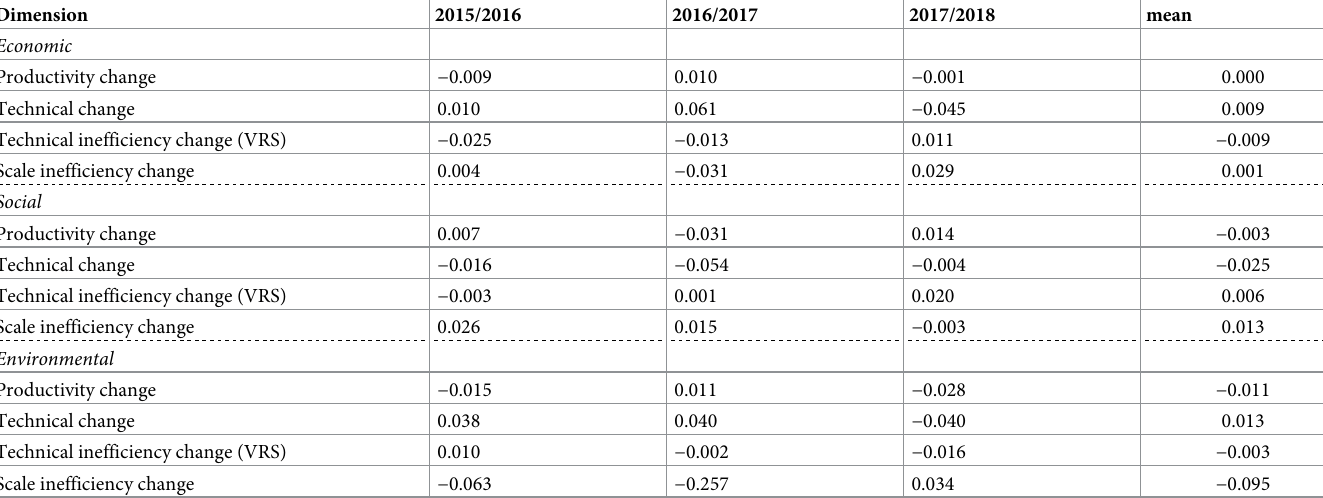
Table 2. Dynamic sustainable productivity change indicators and their decomposition, 2015–2018.